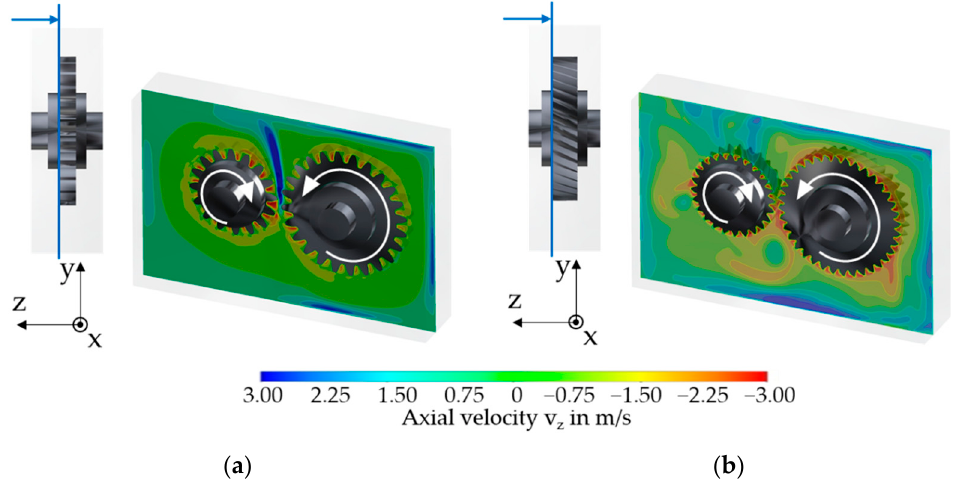
Figure 8. Axial flow velocity (z-direction) on a plane congruent to the side surface for gear-C ( a ) and for gear-LL ( b ) at circumferential speed v t = 10.0 m/s.